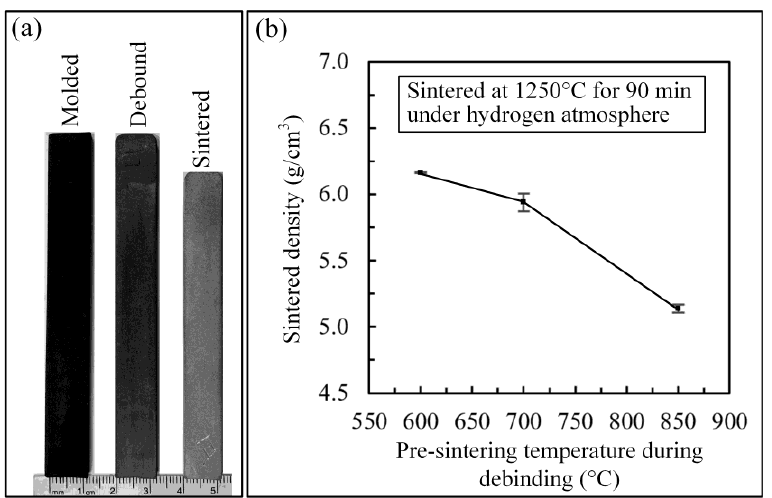
Figure 8. ( a ) Dimensional comparison of injected, debound-pre-sintered at 600 °C, and sintered specimens, ( b ) sintered densities of specimens debound using different pre-sintering temperatures.